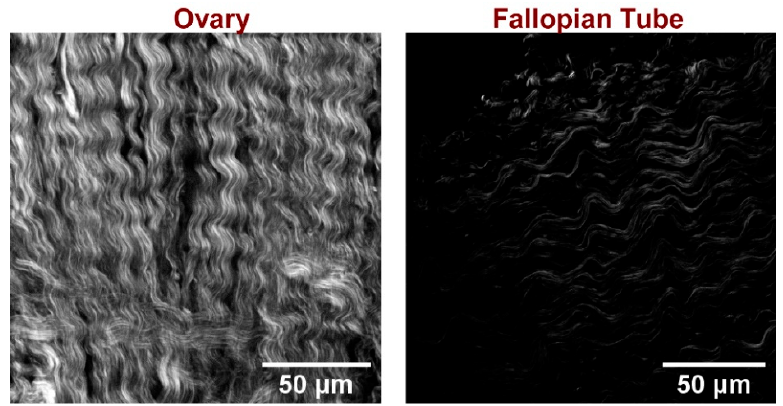
Figure 10. Comparison of single second harmonic generation (SHG) optical sections collected in the forward direction for HGSOC in the ovary ( left ) and fallopian tube ( right ). A similar high-frequency fiber characteristic is seen in both tissues. The SHG in the ovarian image is brighter due to denser collagen.